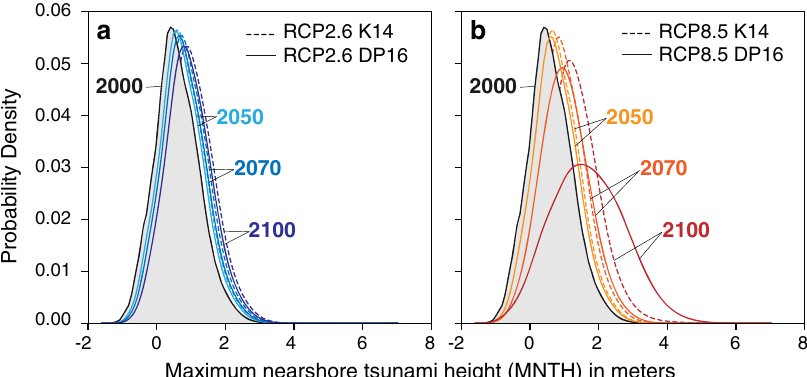
Fig. 3 Normalized distributions of maximum nearshore tsunami heights (MNTH) at the Ports of Los Angeles and Long Beach. The MNTH distribution for 2000 re fl ects the range of possible modeled MNTH, including tidal variability and does not include sea-level rise. MNTH distributions for 2050, 2070, and 2100 are calculated by combining the same range of modeled MNTH with a low-emissions (RCP2.6) sea-level projections with the K14 68 Antarctic Ice Sheet (AIS) contribution and DP16 60 AIS contribution. b high-emissions (RCP8.5) sea-level projections with K14 68 AIS contribution and DP16 60 AIS contribution.